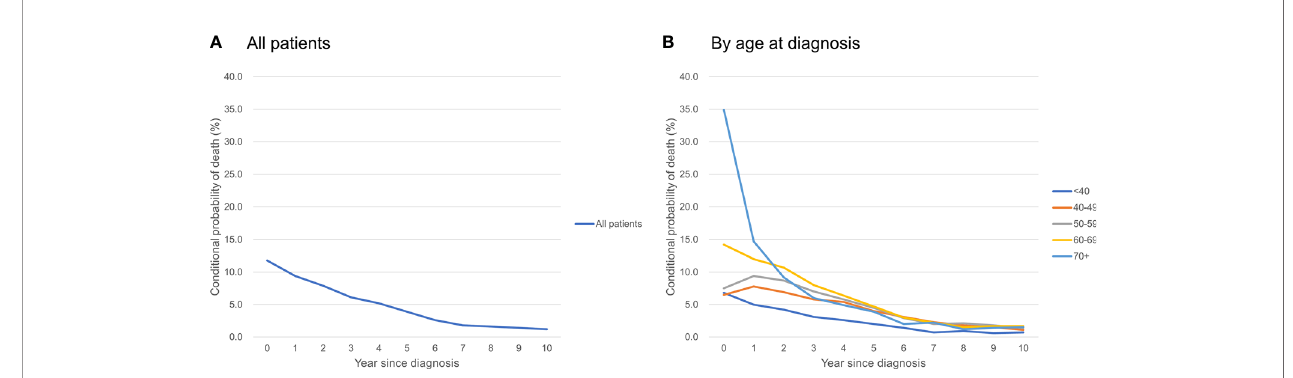
FIGURE 2 | Conditional probability of death of ovarian cancer patients (A) all patients; (B) by age at diagnosis.